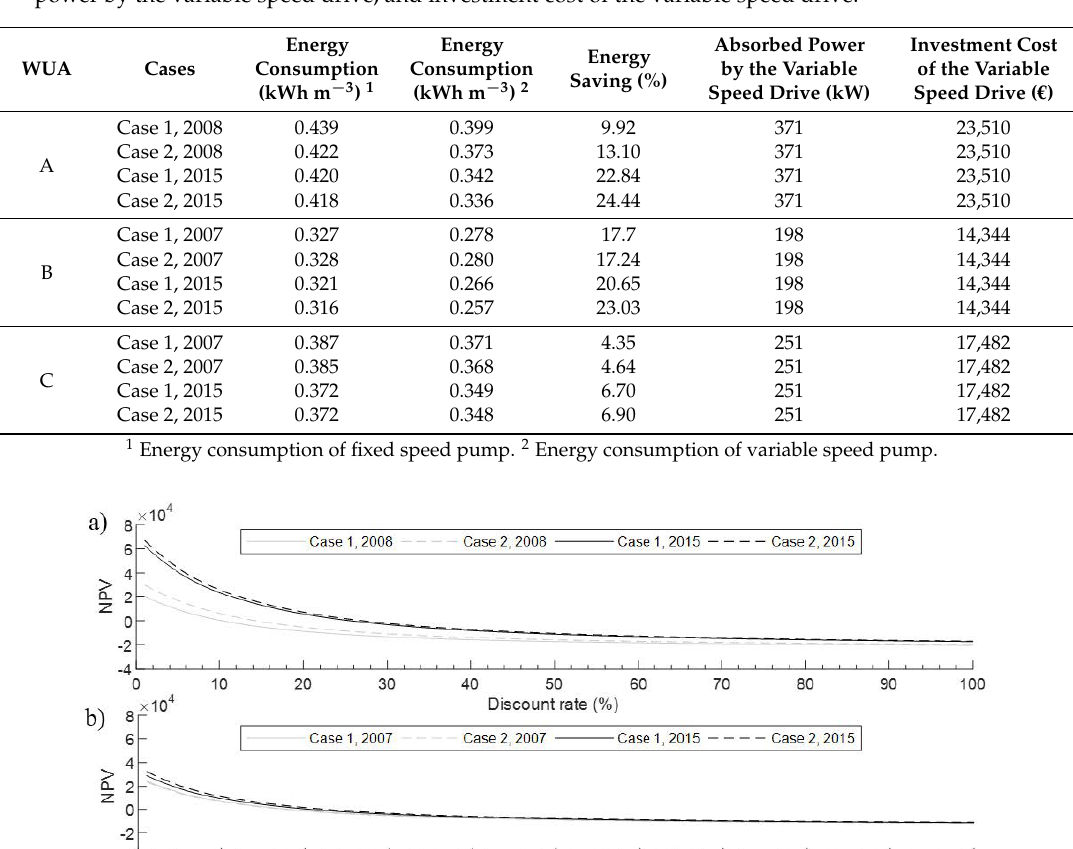
Table 5. Energy consumption of fixed speed pump, variable speed pump, energy saving, absorbed power by the variable speed drive, and investment cost of the variable speed drive.